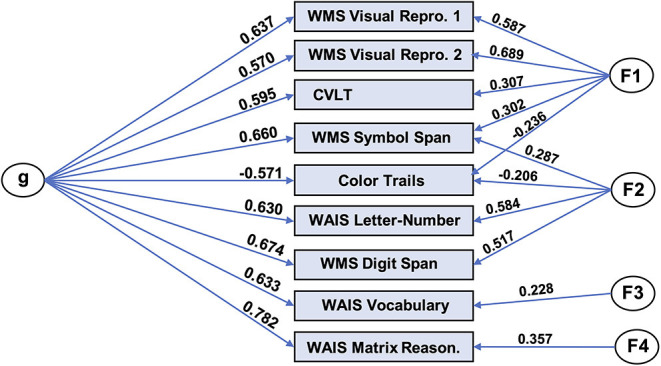
Bifactor model of general intelligence. Bifactor modeling was performed on nine cognitive tasks in the UCLA dataset. The resulting model consisted of a general factor (“g”) and four group factors and exhibited excellent fit with the data. WMS, Wechsler Memory Scale; Repro, Reproduction; WAIS, Wechsler Adult Intelligence Scale; Reason, Reasoning.